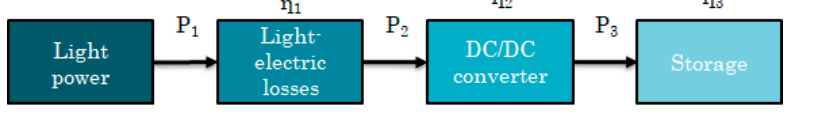
Figure 1. Block diagram of complete DC system.